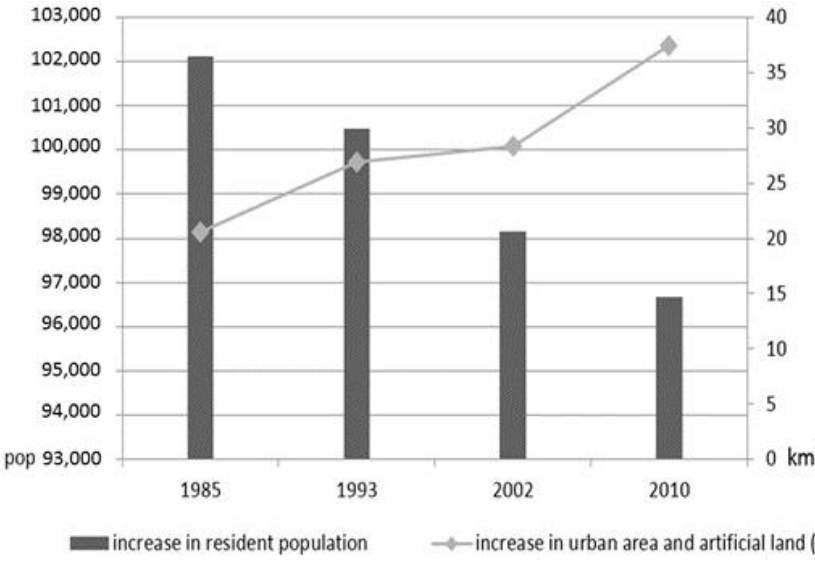
Figure 8. ( a–d )Evolution of urbanized areas in 1985, 1993, 2002 and 2010, respectively.